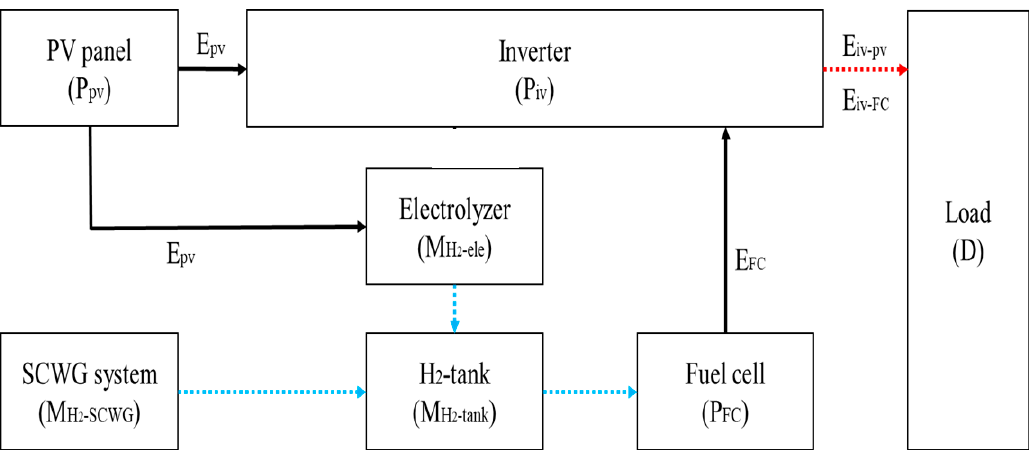
Figure 1. Proposed system configuration.